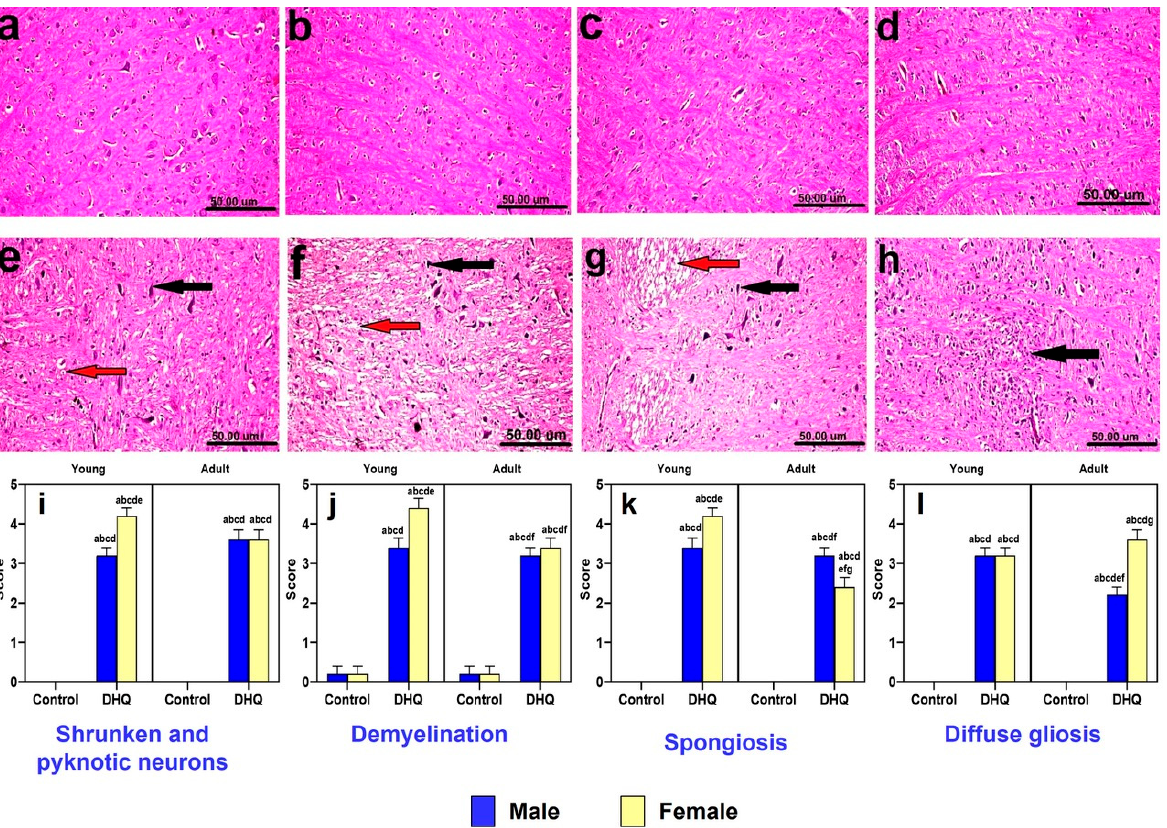
Figure 5. Photomicrograph of hematoxylin and eosin-stained striatum tissue sections of: ( a – d ) control rats ( a ) young male, ( b ) young female, ( c ) adult male, and ( d ) adult female, showing the normal histological picture. ( e ) DHQ young male showing shrunken, atrophied and pyknotic neurons (black arrow) and demyelination (red arrow). ( f ) DHQ young female showing necrosis of neurons (black arrow) and severe demyelination with spongiosis of striatum (red arrow). ( g ) DHQ adult male showing necrosis of neurons (black arrow) and severe demyelination (red arrow). ( h ) DHQ adult female showing diffuse gliosis (black arrow) (scale bar 50 um). Graphical representation of histopathological scores for ( i ) shrunken and pyknotic neurons, ( j ) demyelination, ( k ) spongiosis, and ( l ) diffuse gliosis. Each bar with a vertical line represents the mean ± S.D. of 5 rats per group. a vs. control young male, b vs. control young female, c vs. control adult male, d vs. control adult female, e vs. treated young male, f vs. treated young female, and g vs. treated adult male using three-way ANOVA followed by Tukey’s post hoc test; p < 0.05. DHQ;